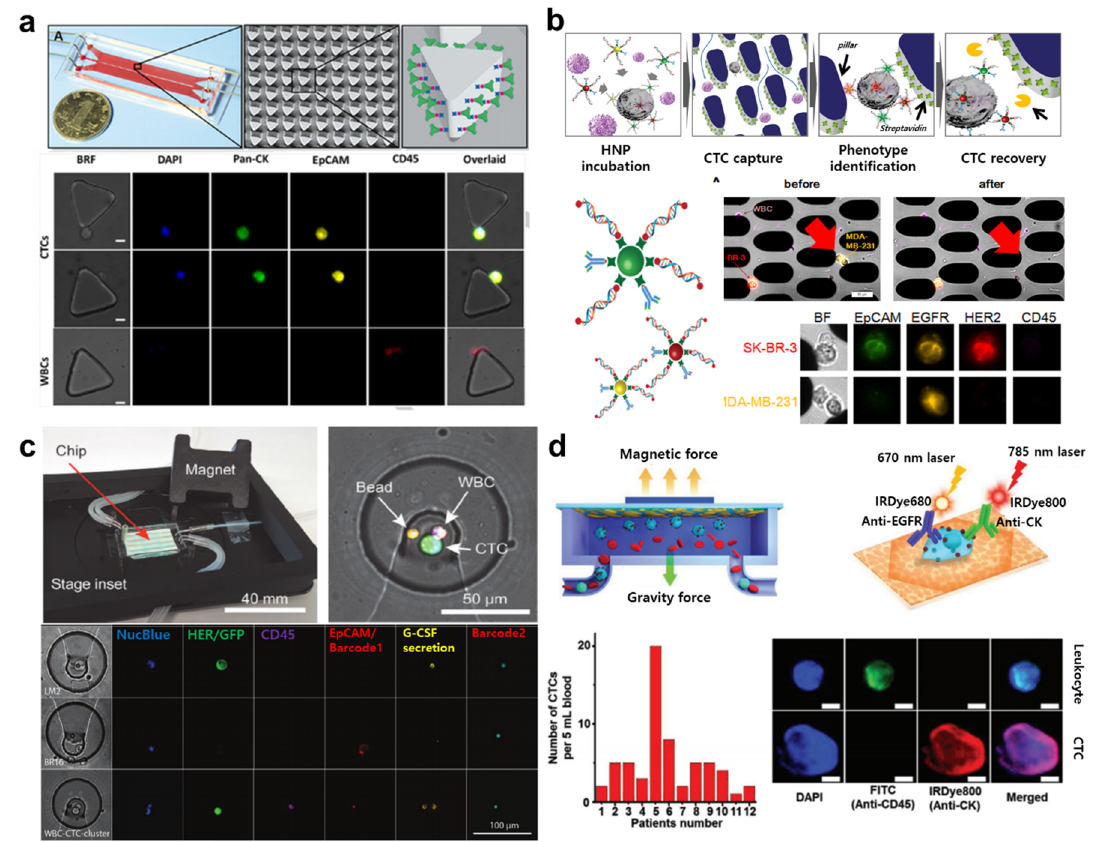
Figure 3. ( a ) Schematic images of size-dictated immunocapture chip (SDI-Chip) and analysis of surface marker of captured CTCs. This figure is reproduced from [74] (© 2017 John Wiley & Sons); ( b ) Schematic images of hybrid nanoparticle-based CTC capture using microfluidic chip and selective recovery of captured CTCs from the microfluidic chip. This figure is reproduced from [64] (© 2013 Elsevier B.V.); ( c ) Microfluidic chip design and operation for CTC capture and protein se-